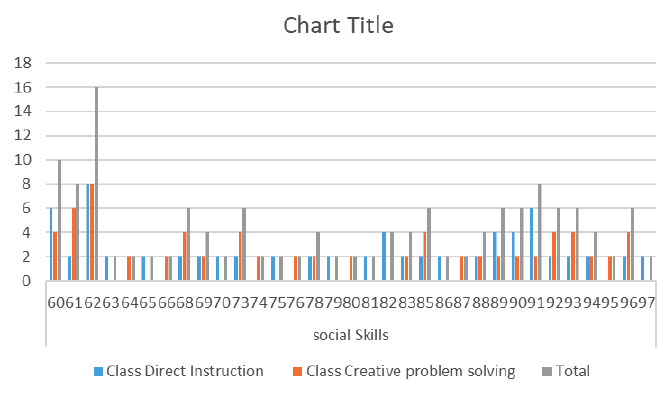
Figure 2. Statistics of social skills (source: created by